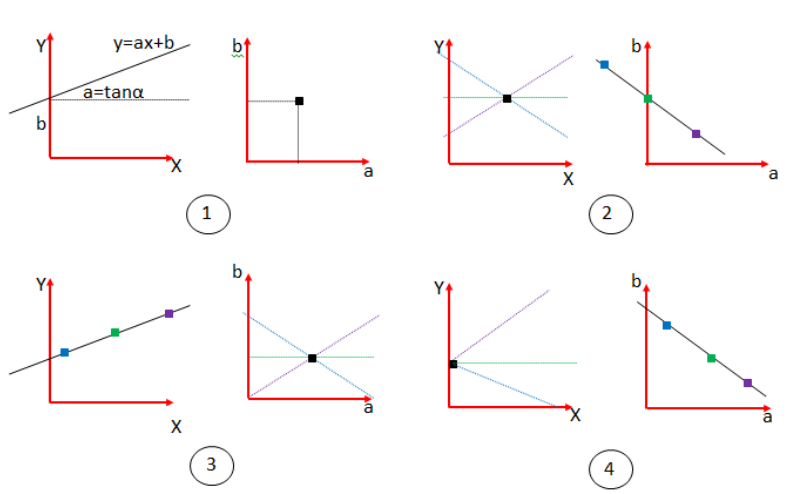
Figure 5. Interpretation of several cases of the Hough Transform applied to straight lines. For each of the four cases, the Image Space is represented at the left and the Parameter Space is represented at the right. In the Image space, there can be seen: ( 1 ) A straight line;